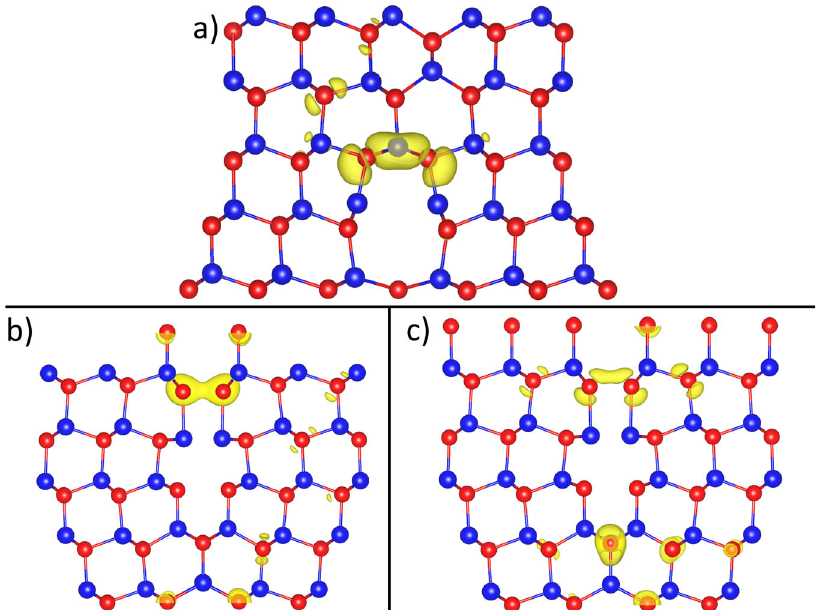
Fig. 9 Partial charges at the grain boundaries with a stacking fault layer present. a cross-boundary Te – Te interaction in the Cd-core responsible for the defect level at ≃ − 0.6 eV in Fig. 8. b cross-boundary Te – Te interaction in the Te-core partially responsible for the defect level between − 0.6 and 0 eV in Fig. 8. c Te defect caused by a non-standard Cd bond angle at the bottom of the Te-core partially responsible for the defect level between − 0.6 and 0 eV in Fig. 8. Cd: Blue, Te: Red, yellow: charge